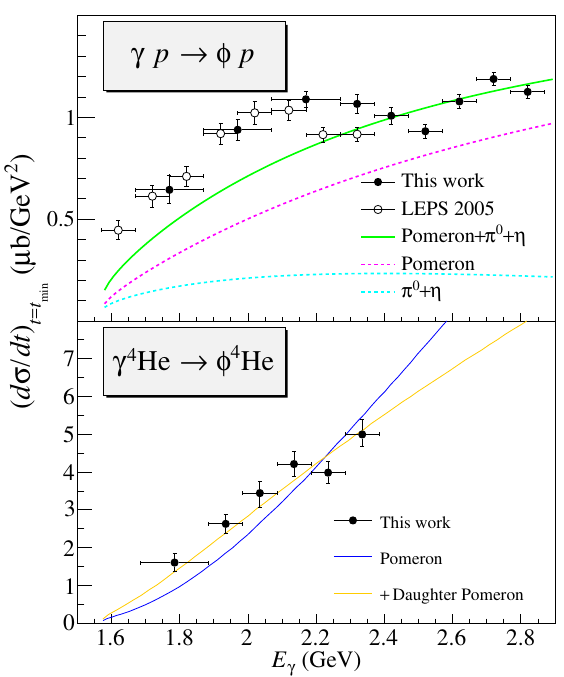
Figure 1. Energy dependences of ( d σ/ dt ) t = t 4 He (bottom) [8,